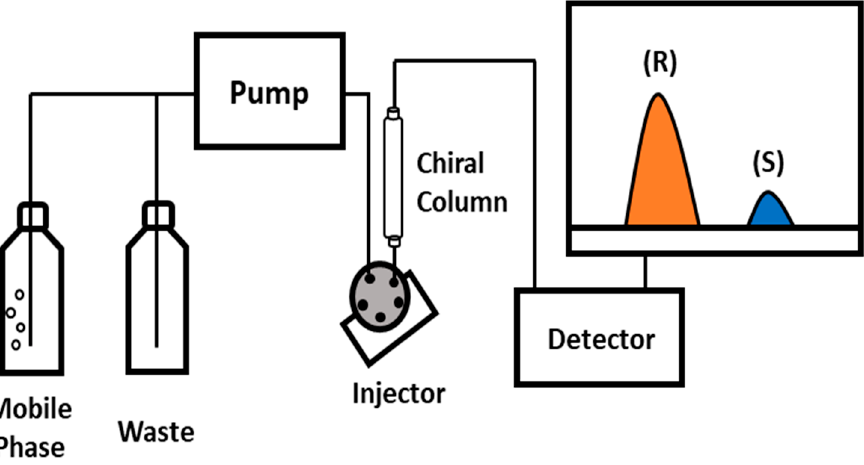
Figure 2. High Performance Liquid Chromatography to analyze the composition of the permeate. Racemic compounds were separated using a mixed solvent of Hexane/Ethanol/TFA (90:10:0.1, v / v ). The UV monitor wavelength was 254 nm.